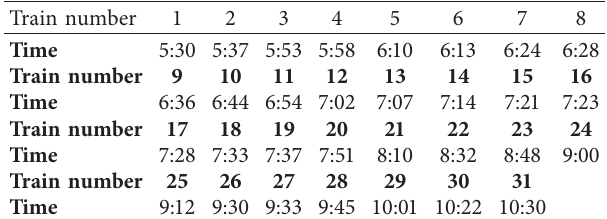
Table 9: Optimised line departure schedule.